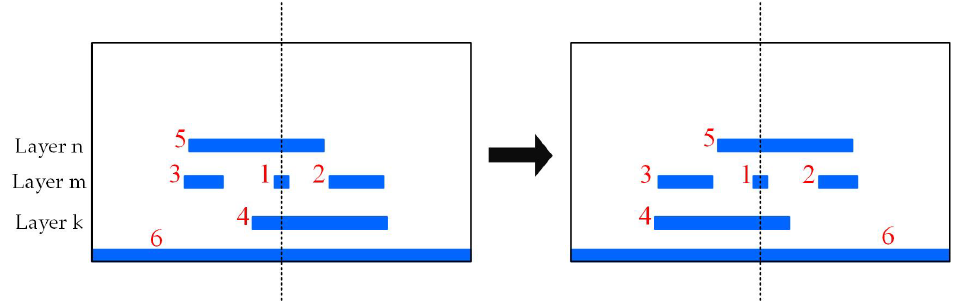
Figure 5. The mirror flip illustration of the studied pattern.